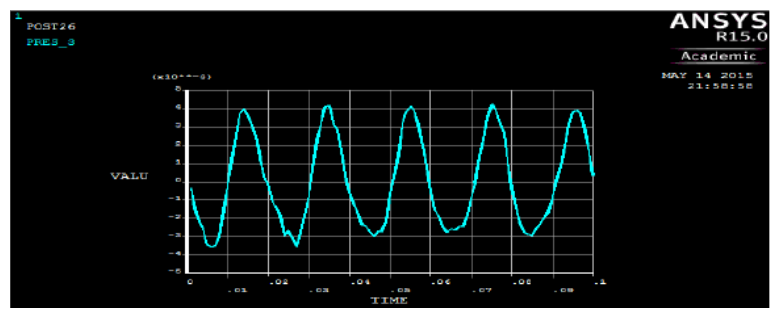
Fig. 2. Pressure variations of the compartment in ANSYS.